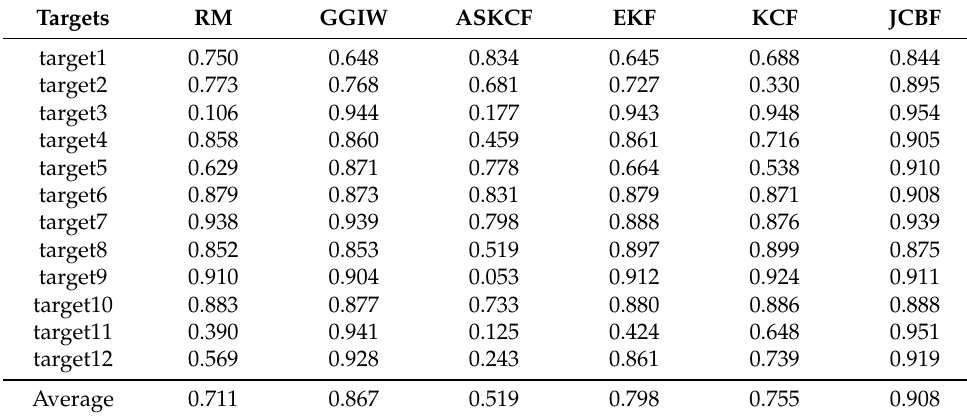
Table 6. Average location precision ( LP ∈ [ 0,1 ] ↑ , ↑ means higher is